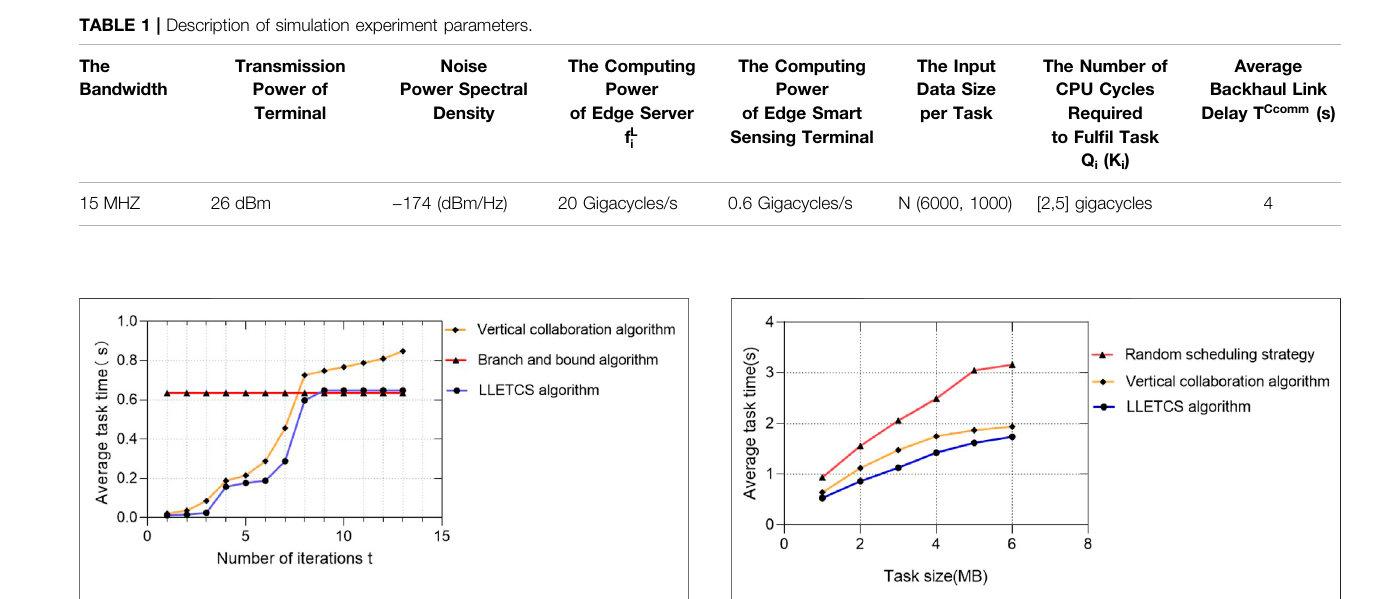
FIGURE 4 | Convergence performance.